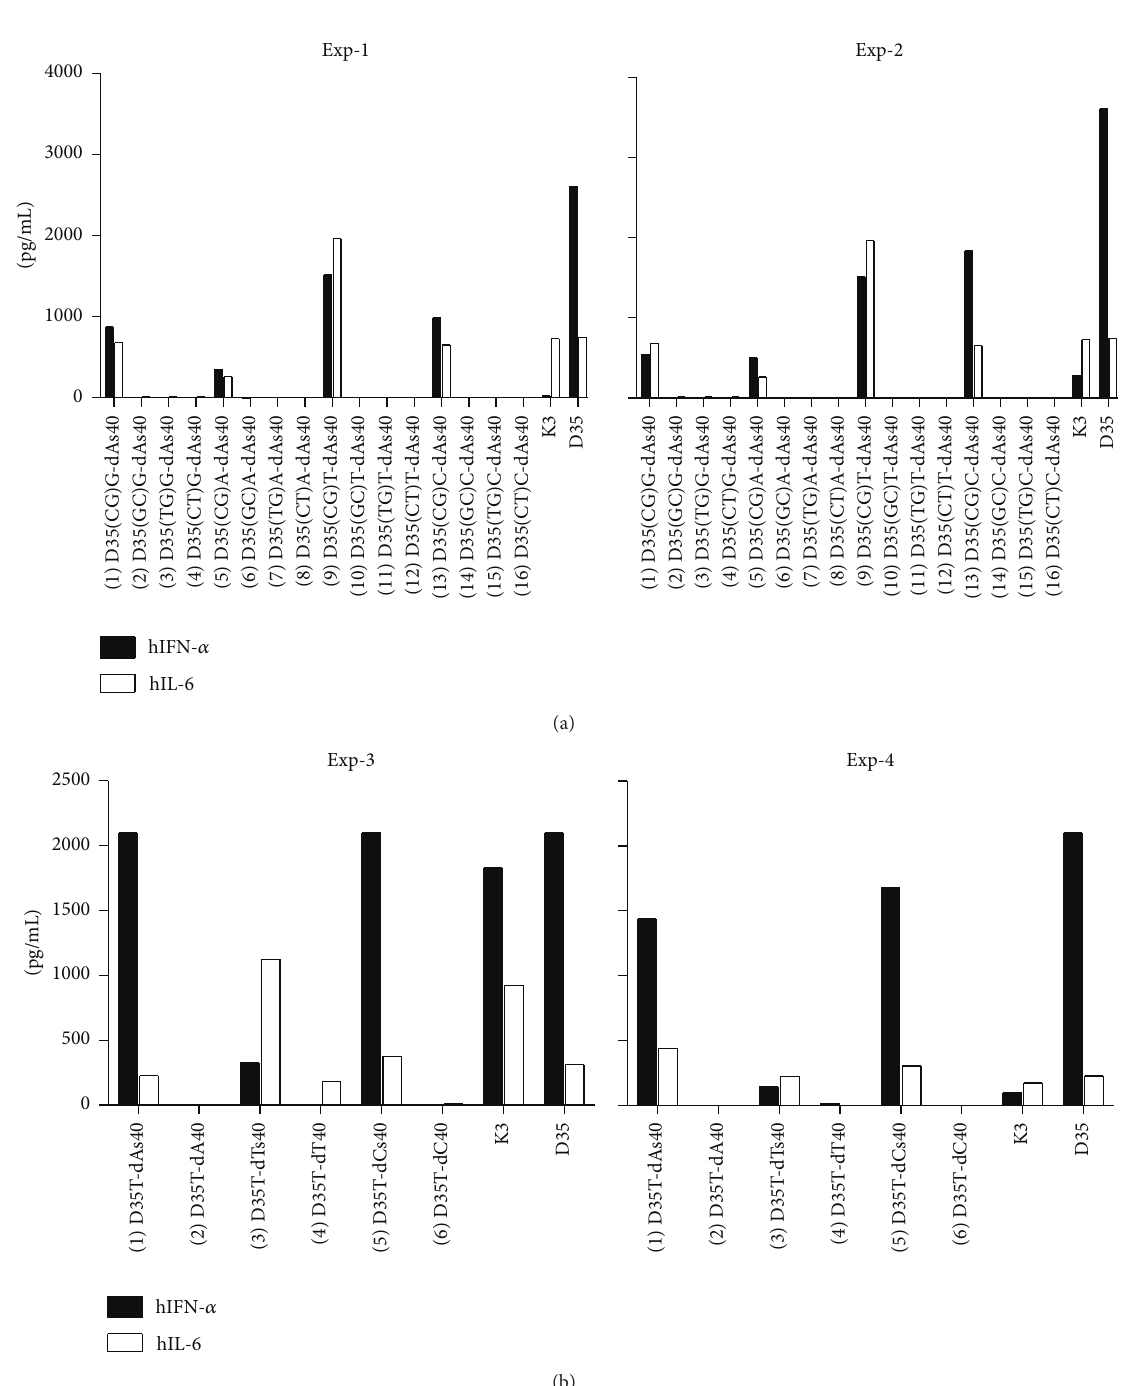
Figure 1: Screening of human PBMC with several different polynucleotide tailed A/D type ODNs. Human PBMCs were stimulated with the indicated synthetic ODNs (1 𝜇 M) (Table 1) for 24 hours. IFN- 𝛼 and IL-6 production in supernatants was measured by ELISA. (a) The requirement of CpG-motifs and G-hexamers for cytokine secretion from human PBMCs. Both IFN- 𝛼 and IL-6 were secreted in a CpG motif dependent but G-hexamer sequence independent manner. (b) Comparison of tail backbones (phosphorothioate or phosphodiester). Cytokine secretion was dependent on phosphorothioate 40-mer tails (1, 3, and 5). ODNs with phosphodiester 40-mer tails showed almost no biological activity (2, 4, 6). The bar graphs indicate the concentrations from a single well of each stimulation. The results are representative of three different experiments consisting of two different donors (Exp-1 and Exp-2, Exp-3 and